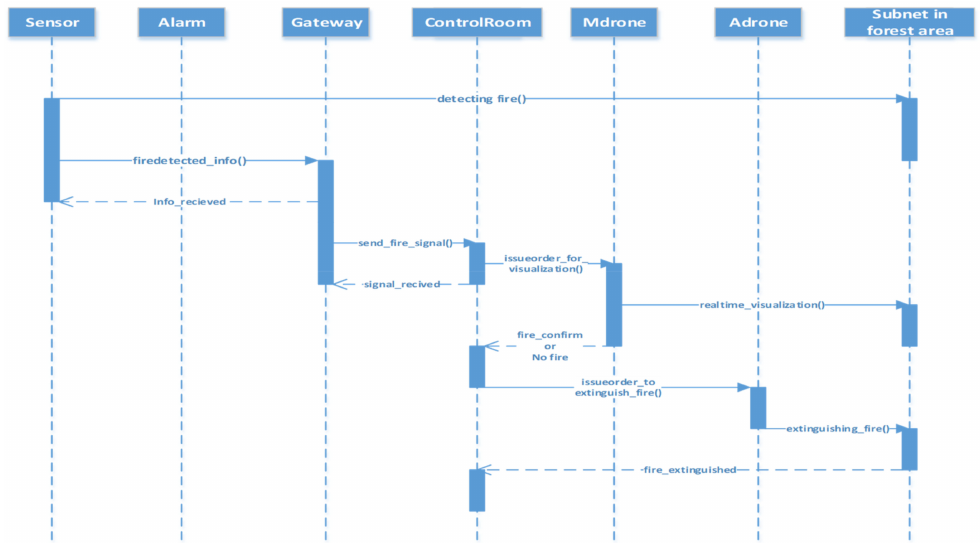
Figure 2. Sequence diagram of forest fire detection and counteraction.